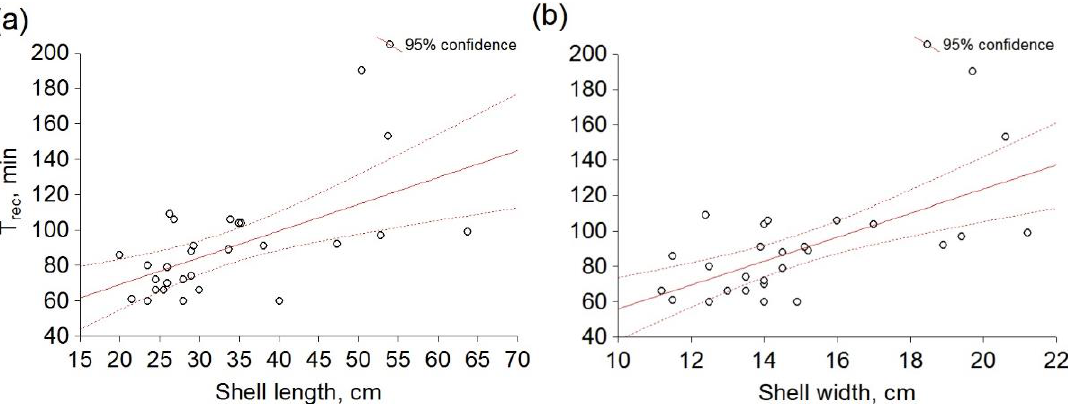
Figure 6. Relation between heart rate recovery time (T rec ) and antero – posterior ( a ) shell length, ( b ) shell width of Pinna nobilis . Circles represent mean values obtained in six independent experi- ments.